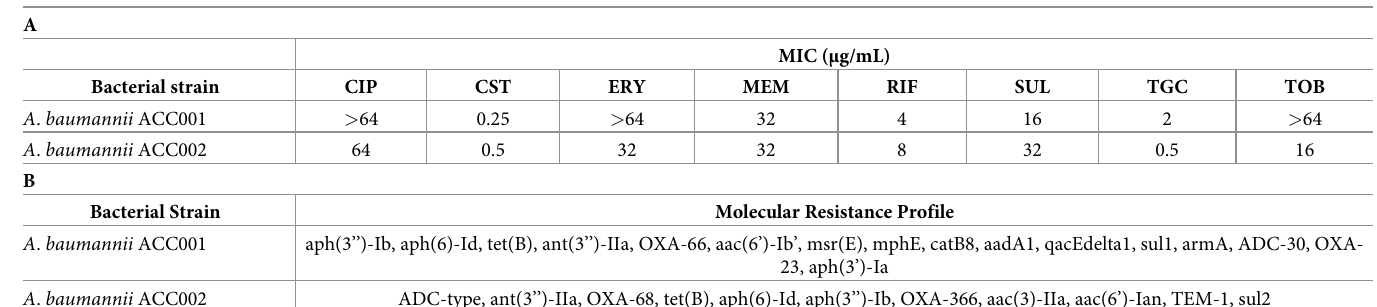
Table 1. Susceptibility (A) and resistance (B) profile of A . baumannii strains